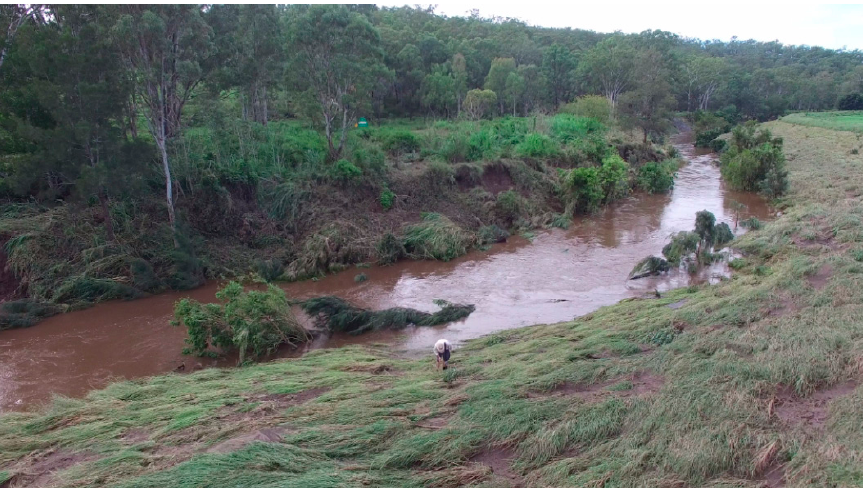
Figure 5. Drone image facing upstream from the study site clearly showing channel degradation along the far (natural) bank and the relatively intact nature of the near (rehabilitated) bank after the major flood event.